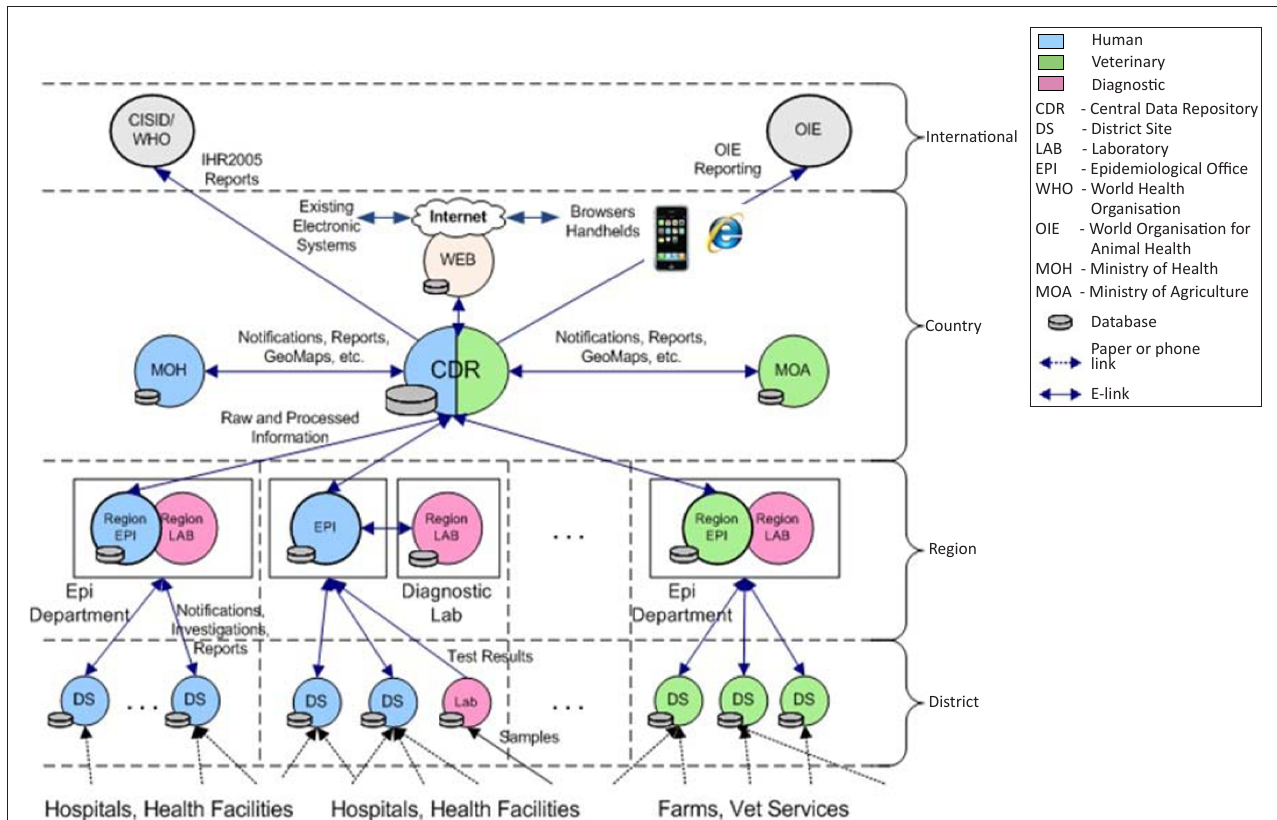
FIGURE 1: Typical Electronic Integrated Disease Surveillance System